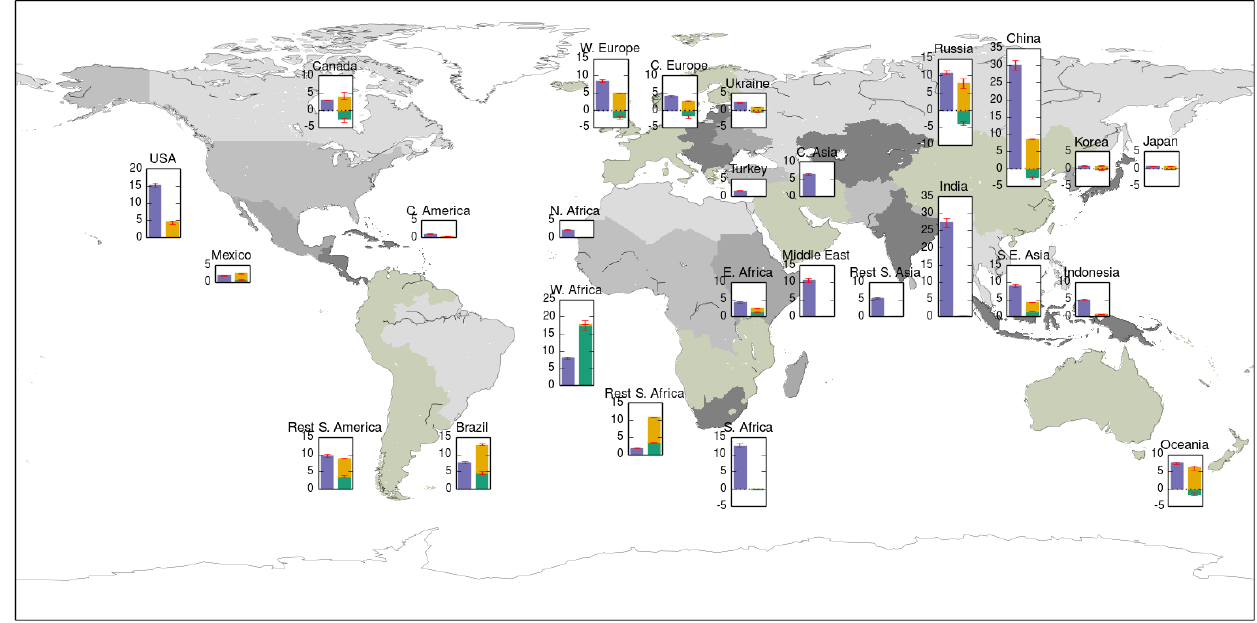
Figure 11. The contribution to the allowable carbon emission budgets (GtC) between 2015 and 2100 for each of the 26 IMAGE IAM regions from methane mitigation (purple bars) and land-based mitigation options (green: natural land uptake; yellow: BECCS with κ = 3) for the temperature pathway stabilising at 1.5°warming without overshoot. The bars and error bars show the median and the interquartile range, respectively, from the 136-member